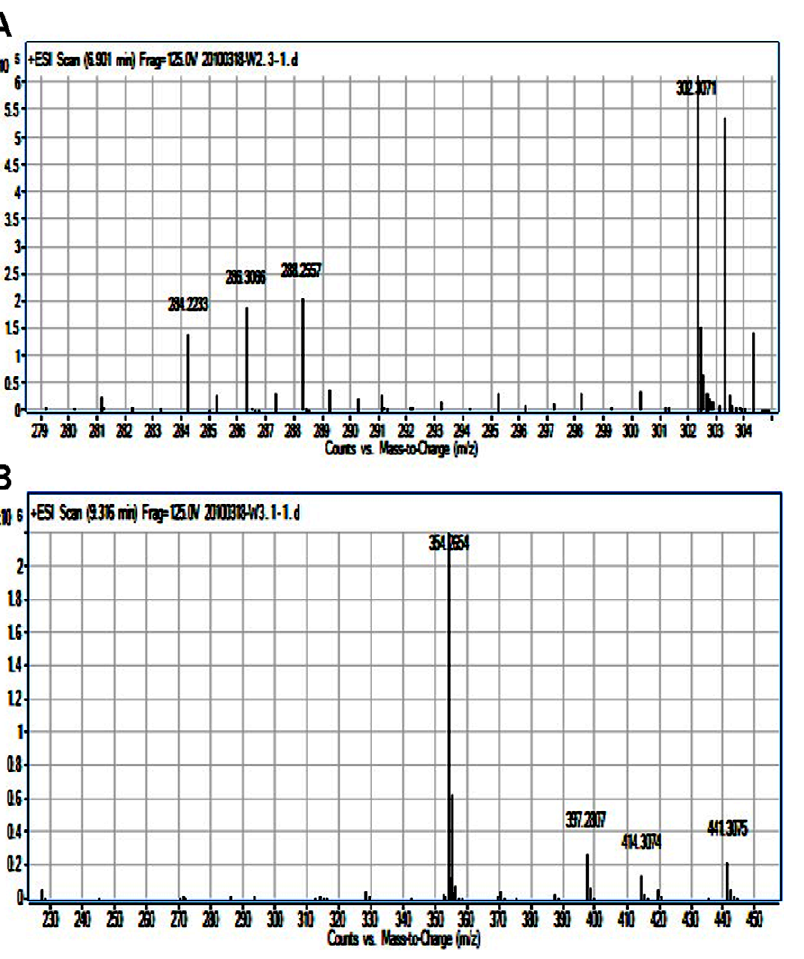
Figure 5. High resolution mass spectrometry analysis of AHLs. (A) ESI-MS spectrum of C12-HSL ( m/z :284.2233; 6.90 min) extracted from Serratia sp. W2.3; (B) ESI-MS spectrum of 3-oxo-C16-HSL ( m/z :354.2654; 9.32 min) extracted from Pseudomonas sp. W3.1.